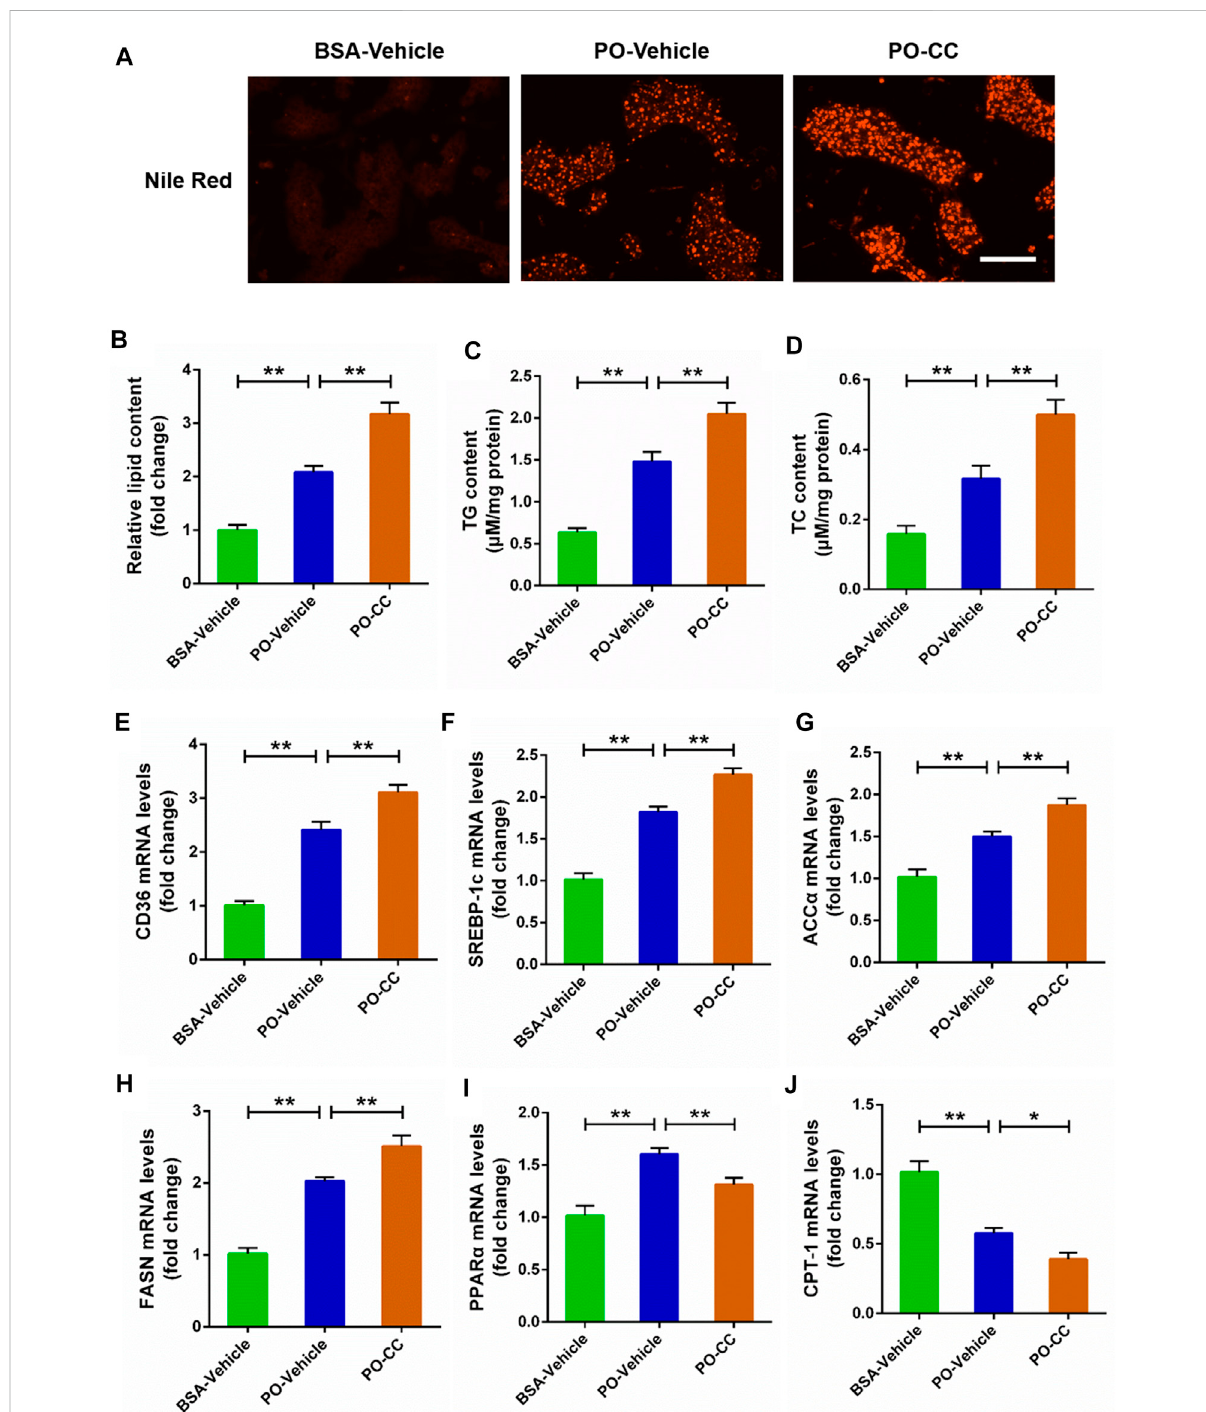
FIGURE 2 Compound C exacerbates the lipid metabolism disorders induced by PO in primary chicken hepatocytes. The primary chicken hepatocytes were pre-treated with/without 10 μ M AMPK inhibitor compound C for 1 h, and then stimulated with/without 0.75 mmol PO for another 24 h. (A) Photography of lipid droplet accumulation by Nile Red staining (scale bars, 100 μ m); (B) Relative of lipid droplet content; (C) Triglyceride (TG) content; (D) Total cholesterol (TC) content; (E) Fatty acid translocase (CD36) mRNA levels; (F) Sterol regulatory element binding protein 1c (SREBP-1c) mRNA levels; (G) Acetyl-CoA carboxylase α (ACC α ) mRNA levels; (H) Fatty acid synthase (FASN) mRNA levels; (I) Peroxisome proliferator activatedreceptor α (PPAR α )mRNAlevels; (J) Carnitinepalmitoyltransterase-1(CPT-1)mRNAlevels.Valuesrepresentthemeans±SE.* p < 0.05and ** p < 0.01, signi fi cantly different between the indicated treatment